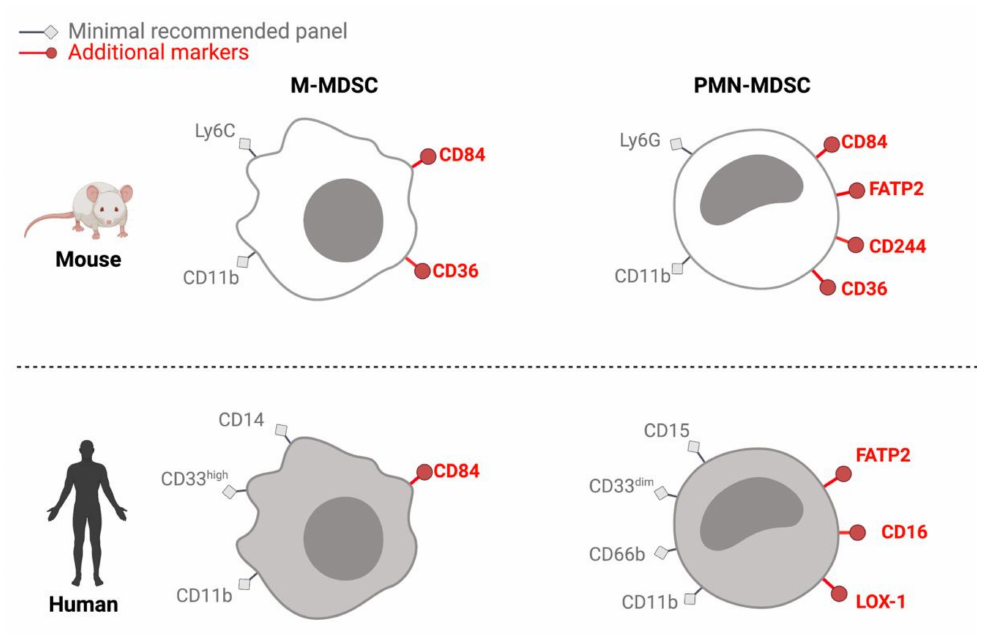
Figure 1. Phenotyping M-MDSCs and PMN-MDSCs in mice and humans . In addition to the recom- mended panel [6], several surface markers are used to further define M-MDSCs and PMN-MDSCs in mice and humans. CD84 is a receptor of the family of signaling lymphocytic activation molecules [26]. FATP2 stands for fatty acid transport protein 2 [27] and CD36 is a fatty acid translocase [28]. CD244 is also known as NK cell Receptor 2B4 [25]. CD16 is the Fc-receptor gamma 3 [8]. LOX-1 is a lectin-type oxidized LDL receptor